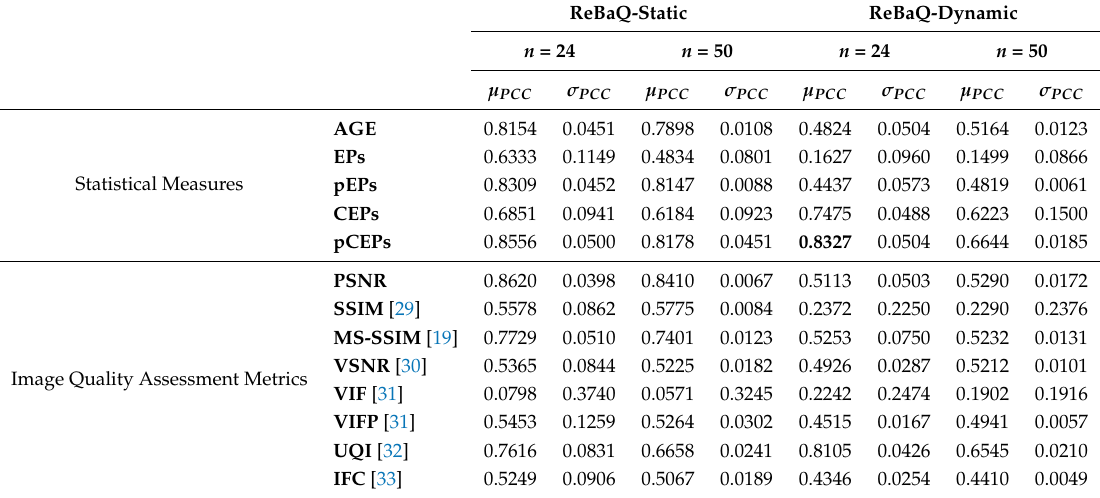
Table 5. Sensitivity analysis on the ReBaQ dataset with n = 24 and n =